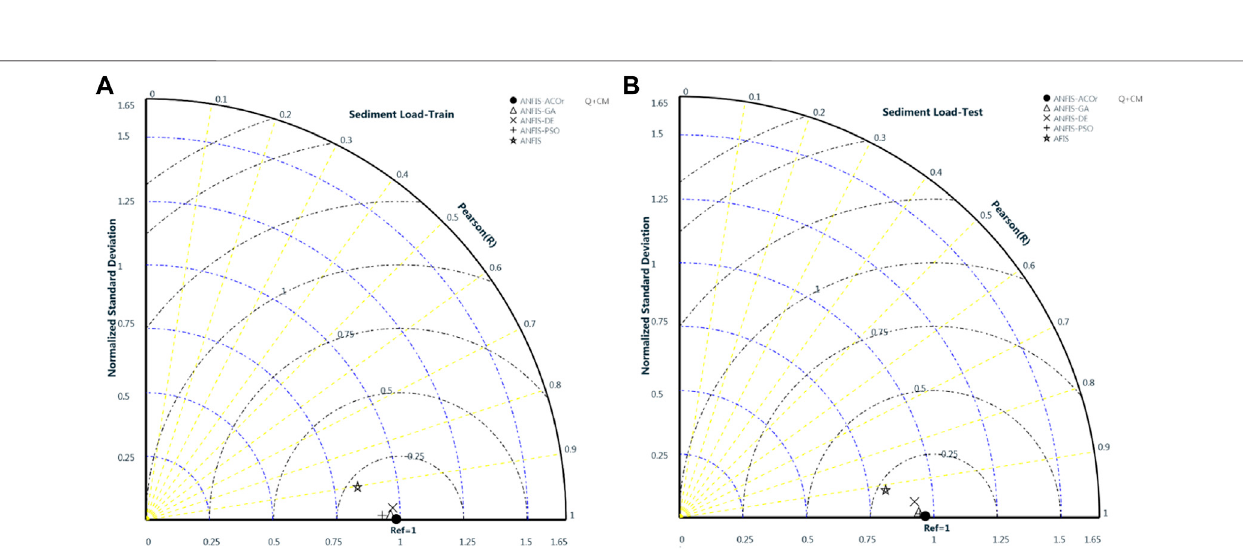
TABLE 3 | Performance of the ANFIS and other hybrid algorithms using dual inputs. Input